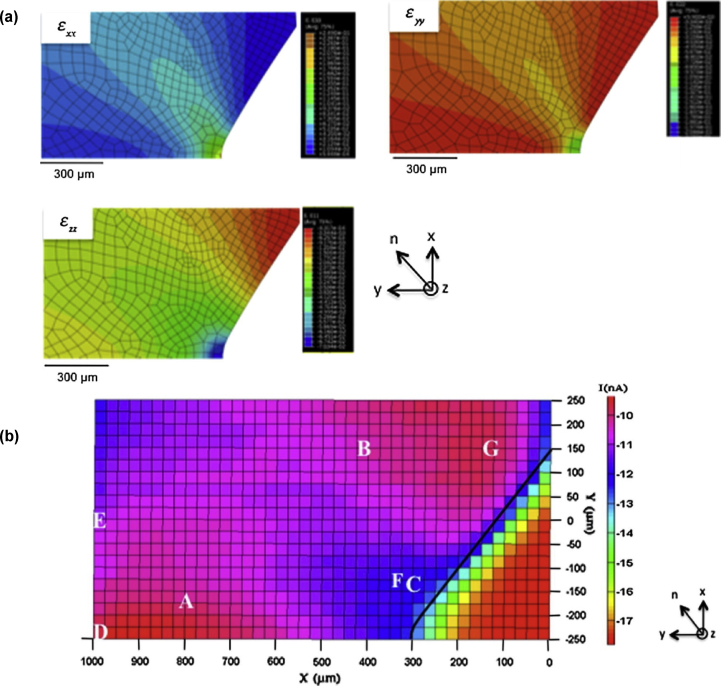
(a) FE modelling showing normal plastic strain at a notch along the x axis, y axis and z axis of a notched 304L stainless steel tensile test specimen; (b) SECM current density map of the notch whilst under tensile stress (470 MPa) in 10 mM K3 [Fe(CN6)]·3H2O + 0.5 M K2SO4. From Sidane et al. [2014].34